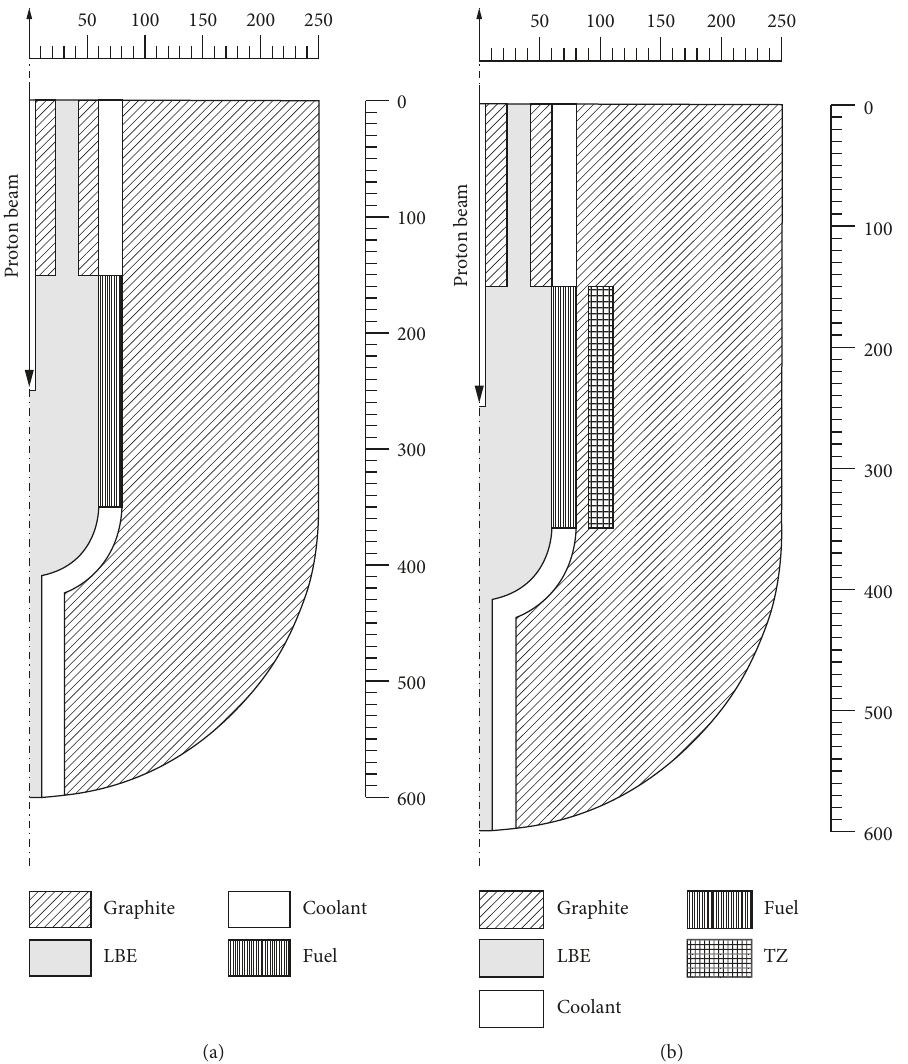
Figure 1: Axisymmetric vertical section views of (a) the original [17] and (b) modified cylindrical ADS (Dimensions are in cm).